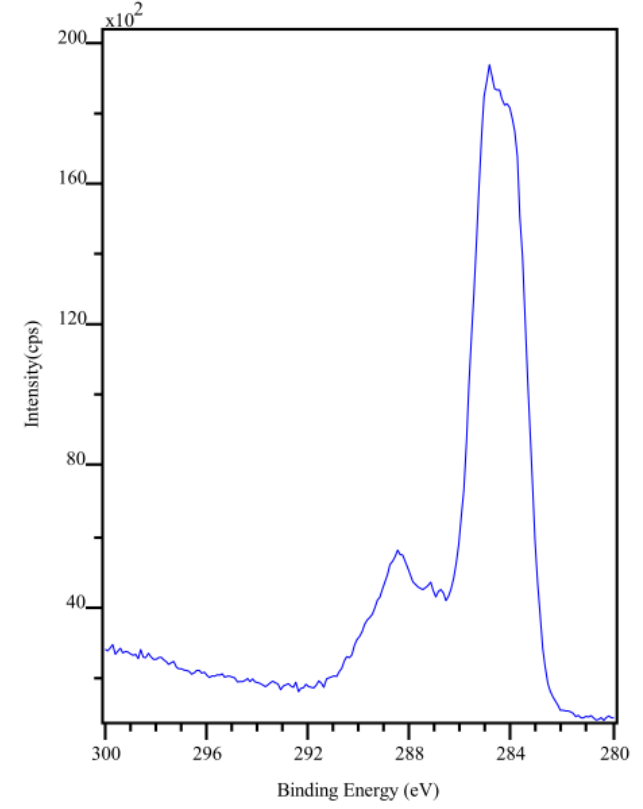
Figure 6. High-resolution XPS scan of the C 1 s transition for (left) Na-Pery. See the text for the contributions at higher-binding energies.